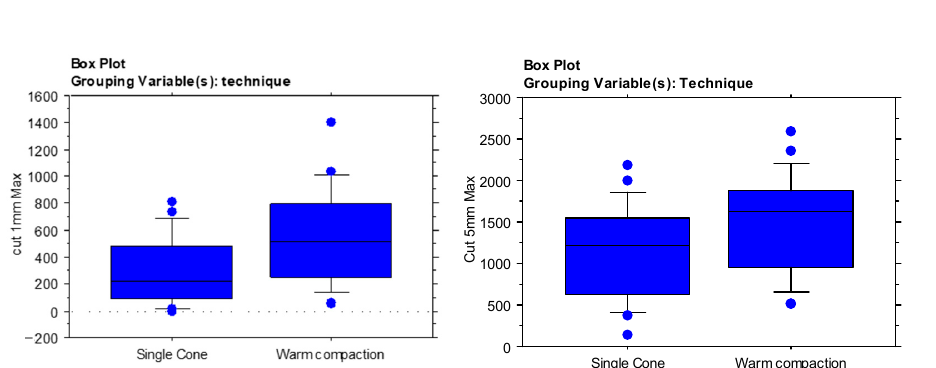
Figure 1. Box plot representation of the sealers penetration depth at 1 mm (left) and 5 mm (right) depending on the obturation